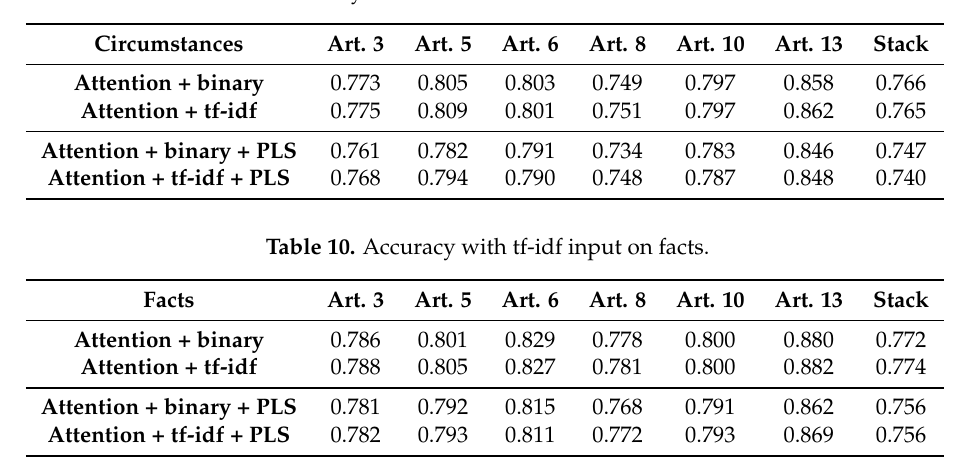
Table 9. Accuracy with attention mecanism on circumstances